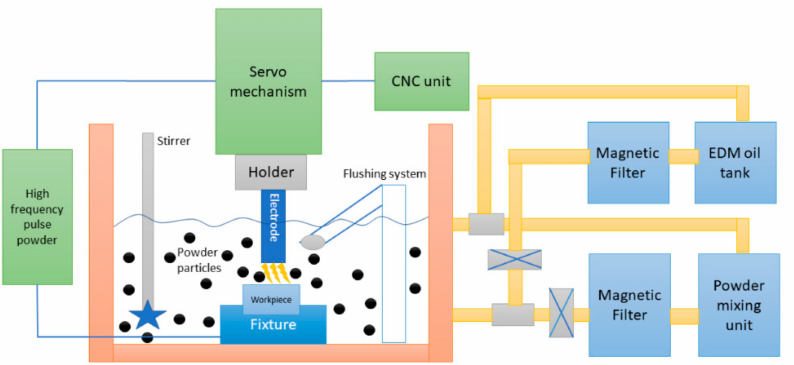
Figure 1. Schematic diagram of the PM-EDM technique reproduced with permission from ref. [57].